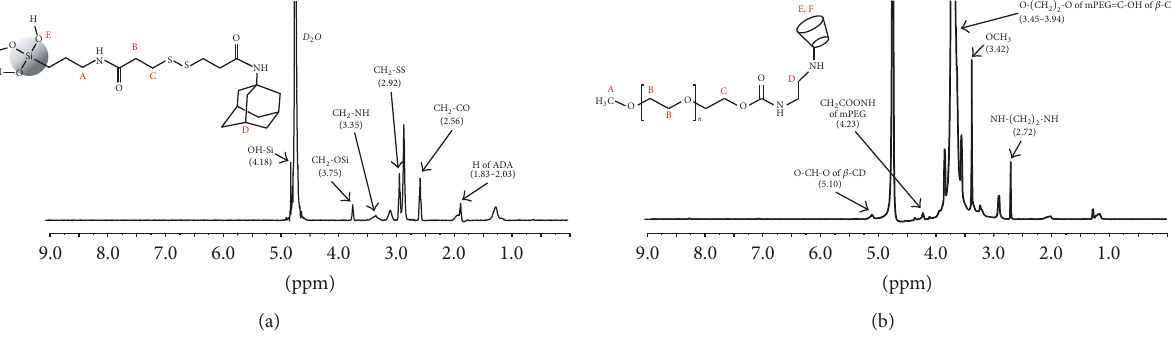
Figure 2: 1 H NMR spectra: PNS-SS-ADA (a); CD-mPEG (b).